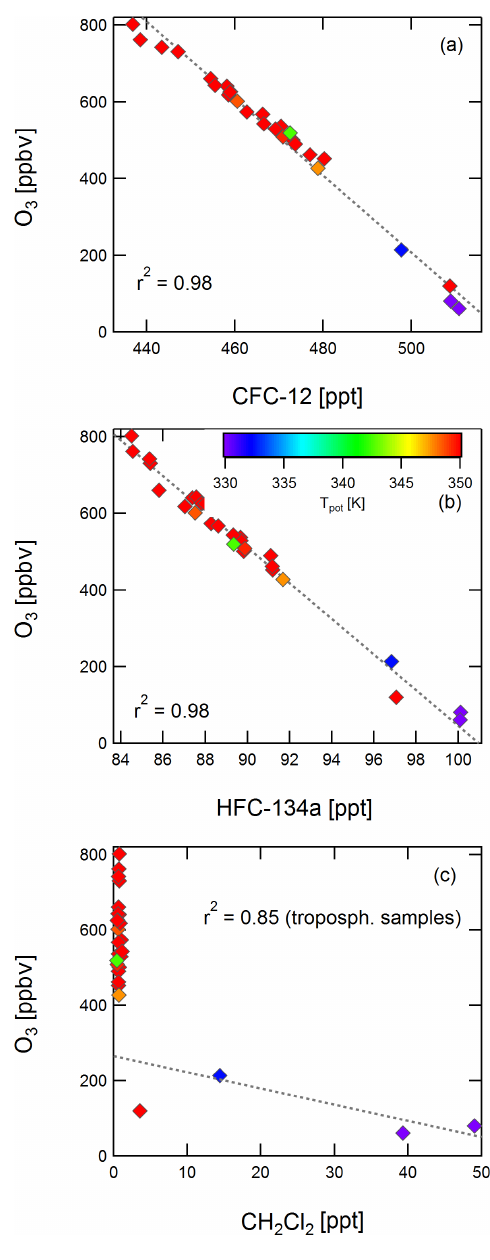
Figure 6. Correlation of CFC-12 (a) , HFC-134a (b) , and dichloromethane (c) with ozone. Colour coding is by potential tem- perature. Values of r 2 are given for the correlation of all samples for CFC-12 and HFC-134a and for three tropospheric samples in the case of